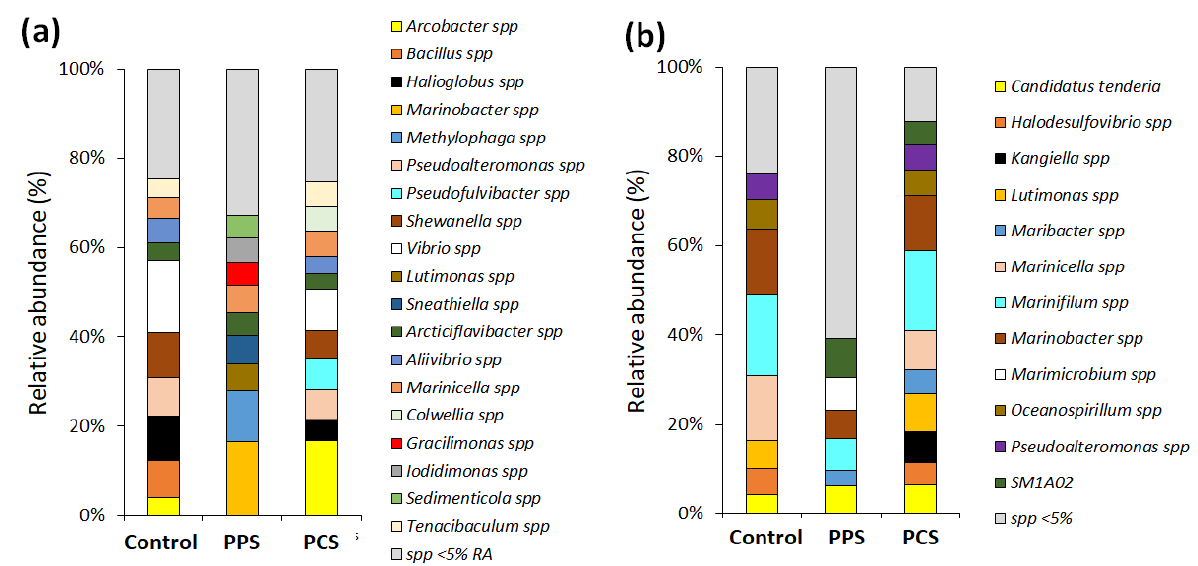
Figure 5. Relative abundances of top genera of bacteria forming biofilm showing relative abundance >5% in the pulse type SMF tests (PPS), continuous type SMF tests (PCS) and control (C) conditions in survey periods. ( a ) Autumn–Winter period; ( b ) Spring–Summer period.